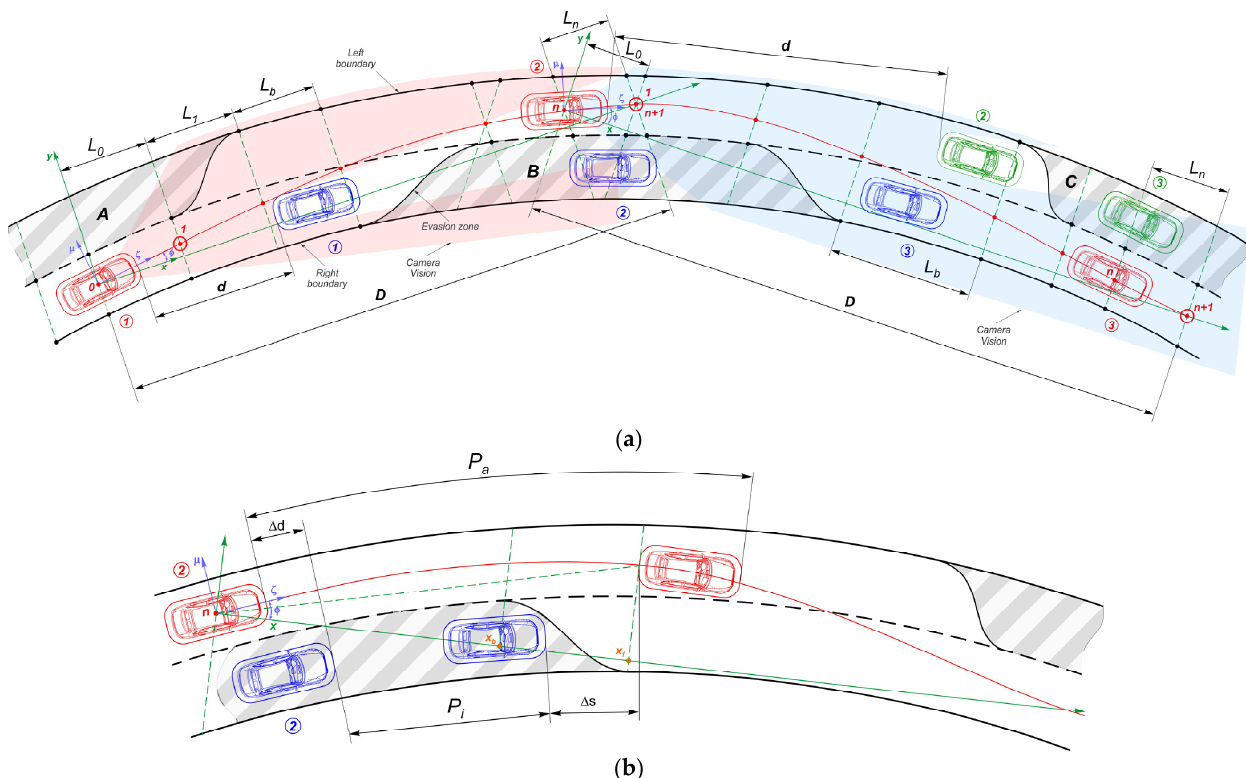
Figure 3. Forming the admissible motion boundaries combined with avoiding obstacles: ( a ) two stages of bypassing obstacles and ( b ) determining the safe zone for an impeding